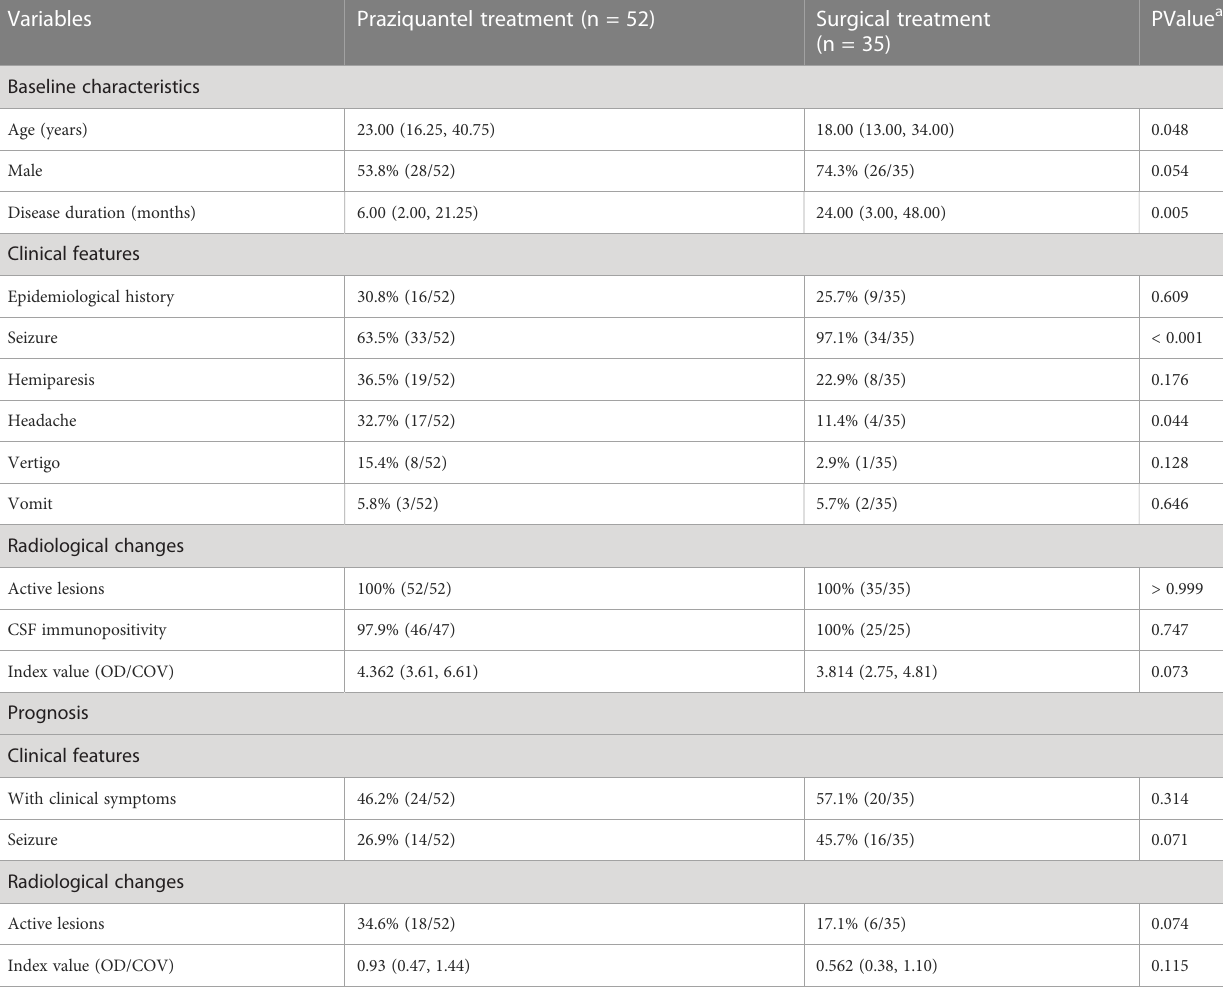
TABLE 1 Baseline characteristics and prognosis in patients with different treatments.